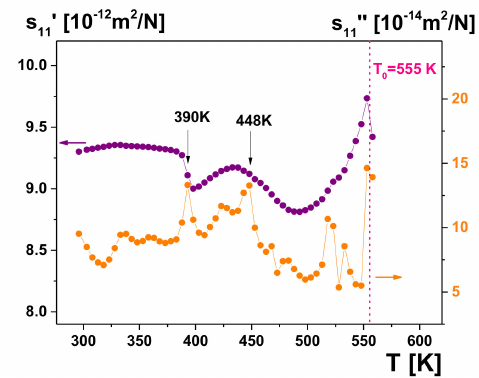
Figure 4. The dependence on temperature of the real s 11 ’ (purple) and imaginary s 11 ” (orange) part of the elastic compliances s 11 for PZT single crystal, determined from recorded piezoelectric resonances at frequencies of the order of hundreds